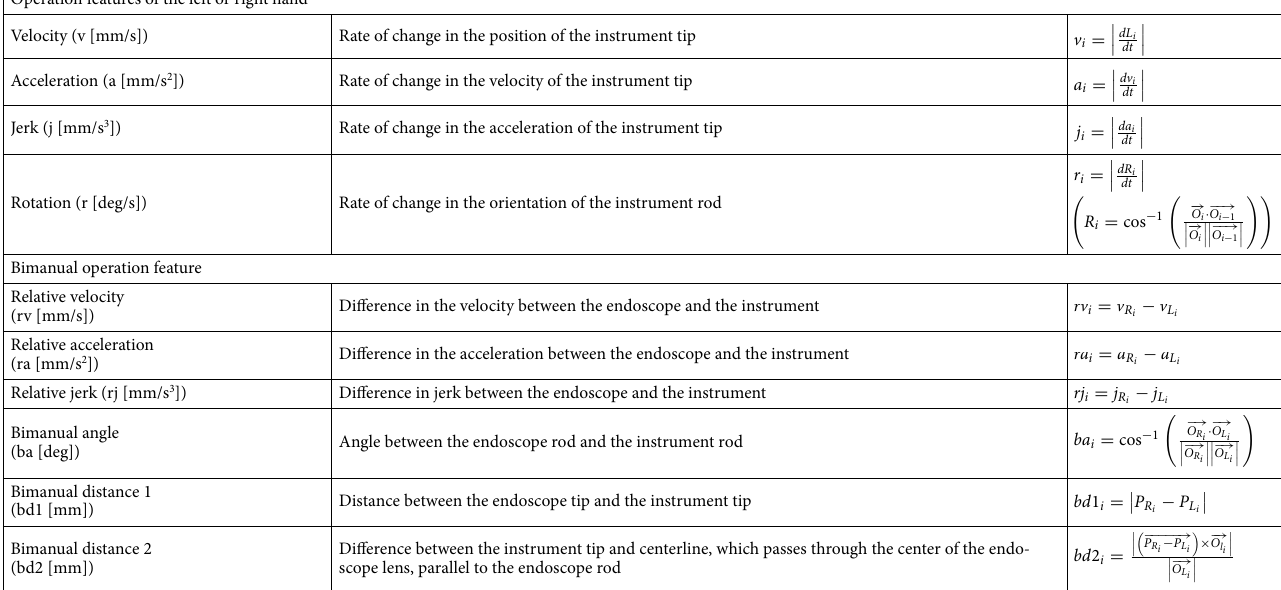
Table 2. Definition of surgical feature parameters 6 .